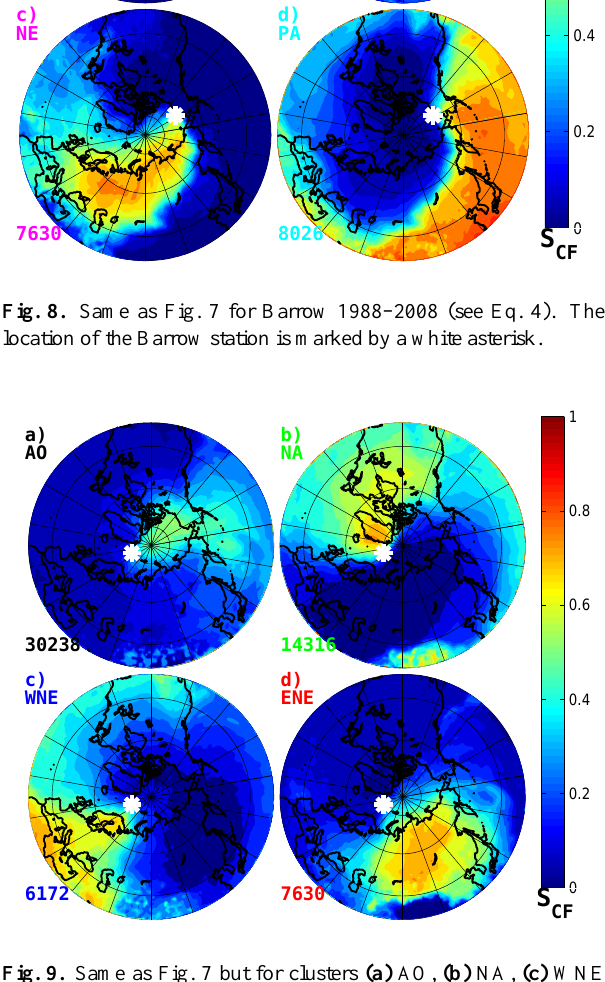
Fig. 9. Same as Fig. 7 but for clusters (a) AO, (b) NA, (c) WNE and (d) ENE for Zeppelin 1990–2009 (see Eq. 4). The location of the Zeppelin station is marked by a white asterisk. AO, Arctic Ocean cluster; NA, North American cluster; WNE, Western North- ern Eurasian cluster; and ENE, Eastern Northern Eurasian